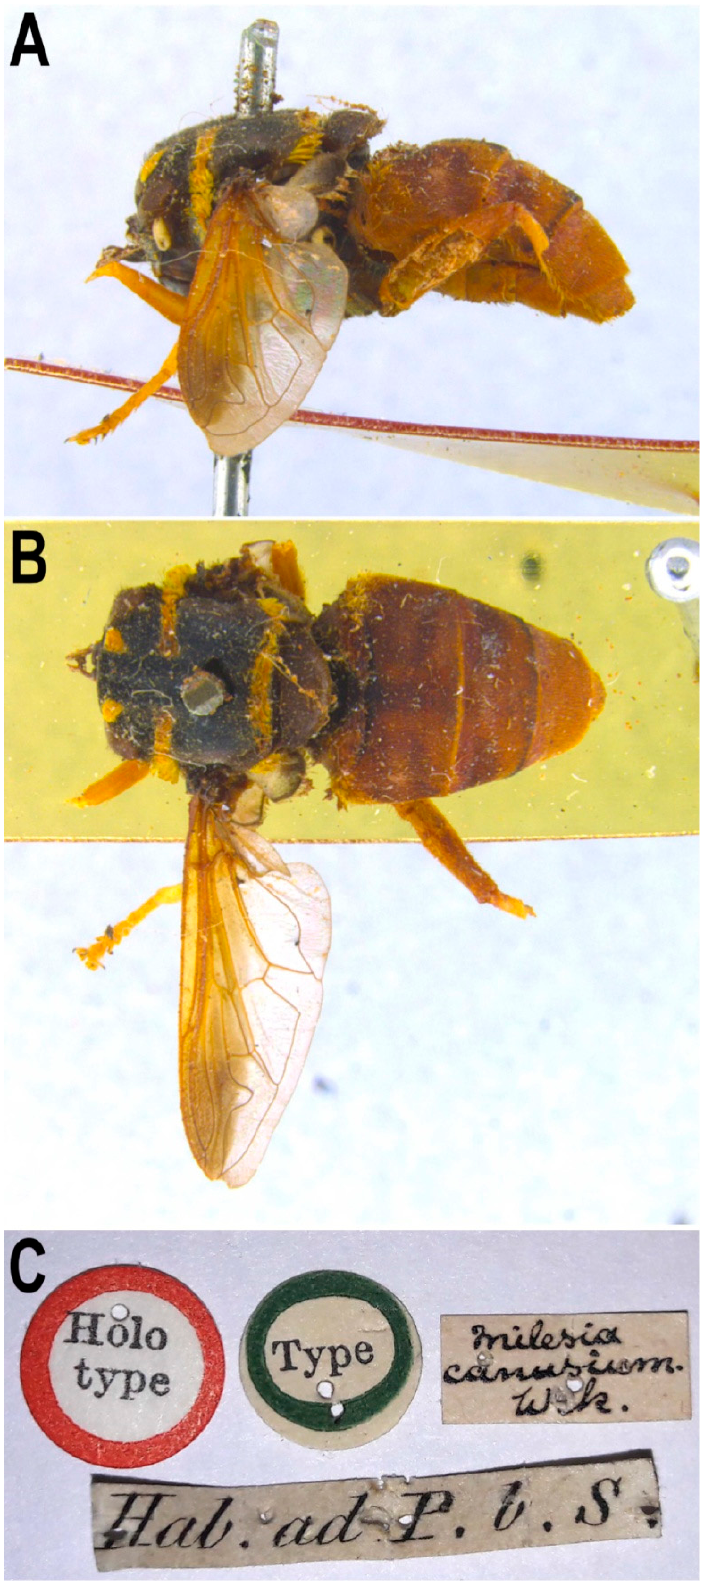
Figure 12. Meromacrus canusium , adult, female holotype. ( A ): entire body, lateral view. ( B ): entire body, dorsal view. ( C ): specimen labels.